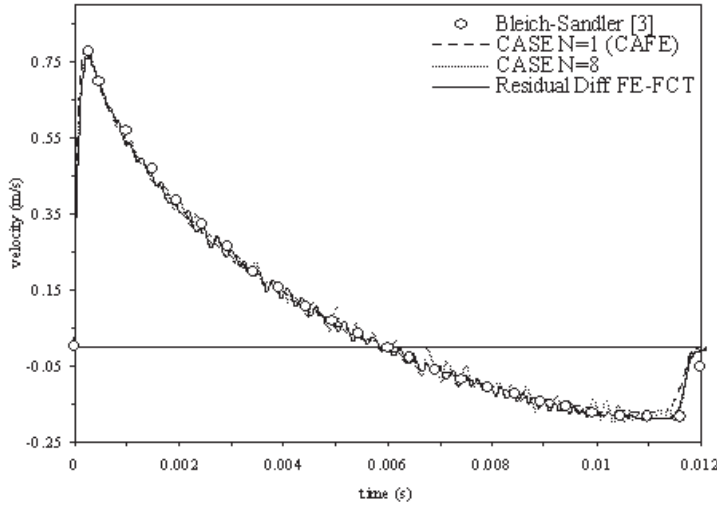
Fig. 15. Bleich-Sandler problem results for the velocity of m 1 using CAFE ( β = 0.50), 8th order CASE ( β = 0.50), and residual diffusion FE-FCT ( η D = 0.125, η A = 0.09).